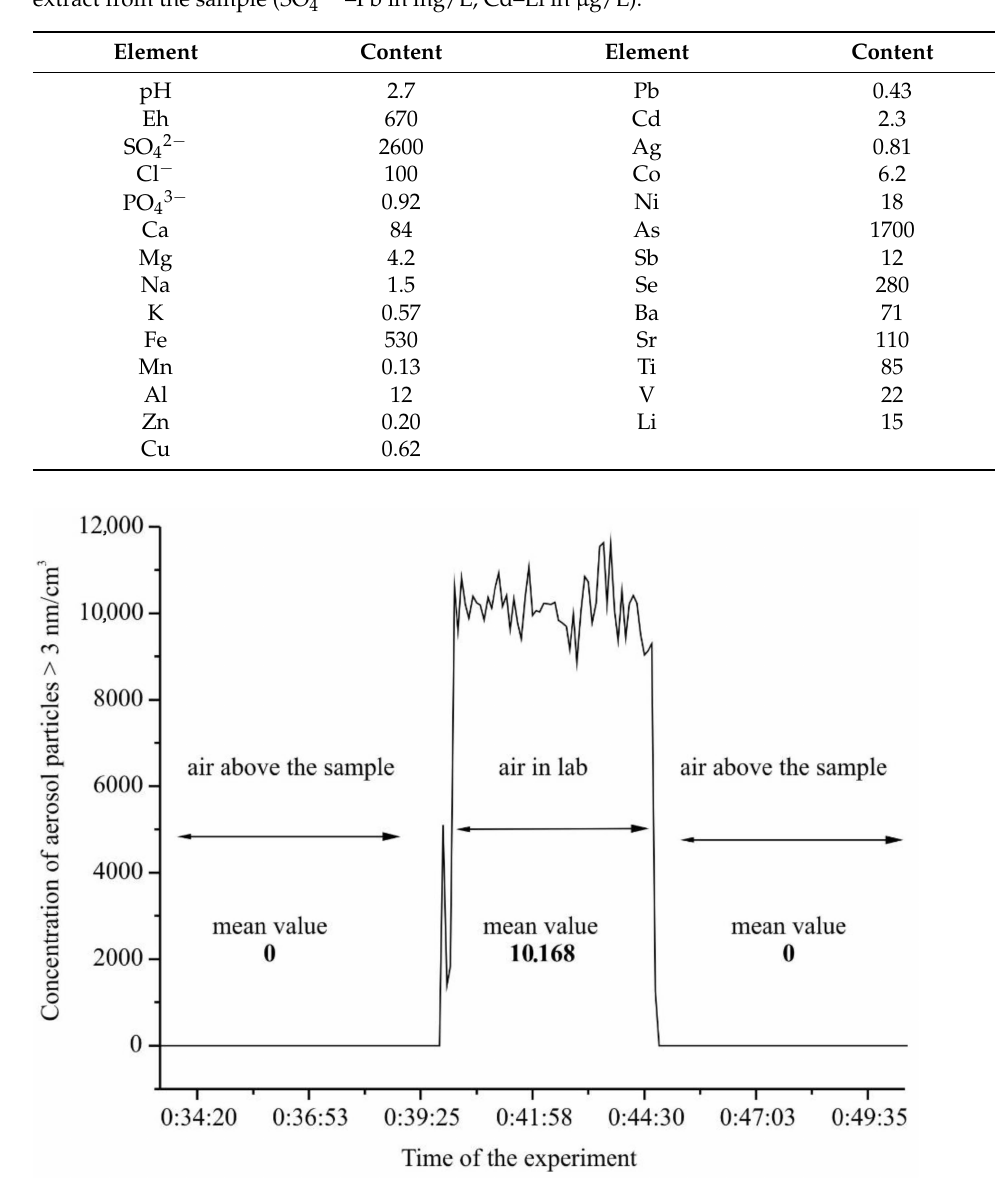
Figure 3. Fragment of the recorder chart of aerosol particles bigger than 3 nm in the air above the sample and in the